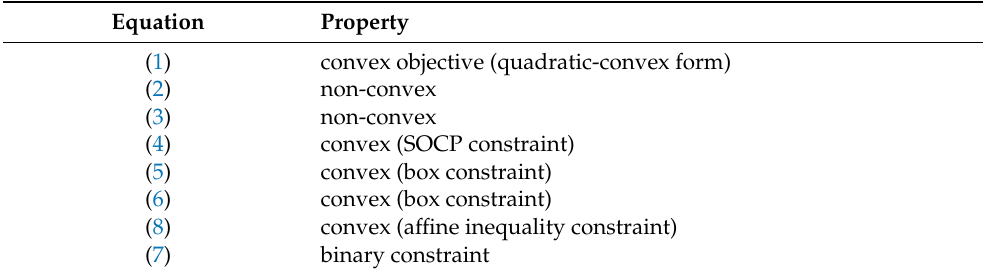
Table 1. Identification of model